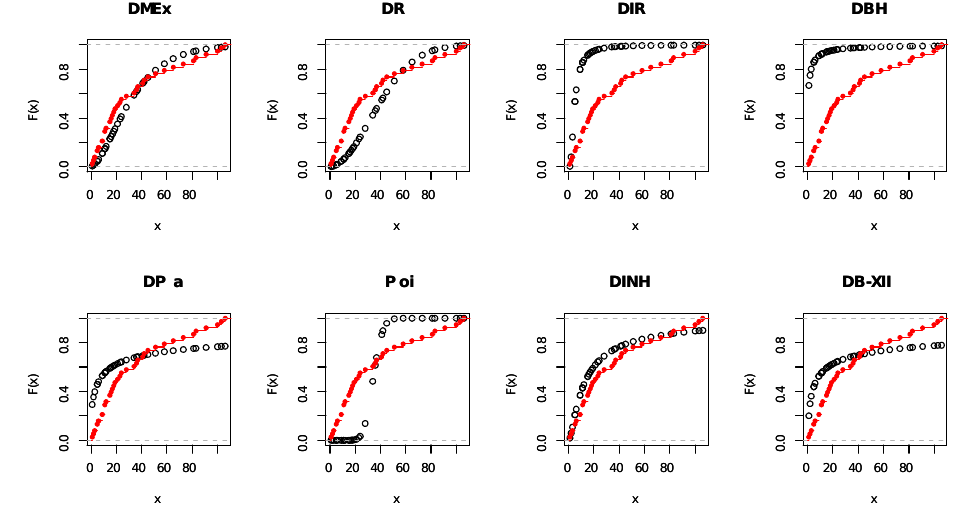
Figure 15 . Empirical CDFs visualization plots for COV-P data. Figure 15. Empirical CDF visualization plots for COV-P data.